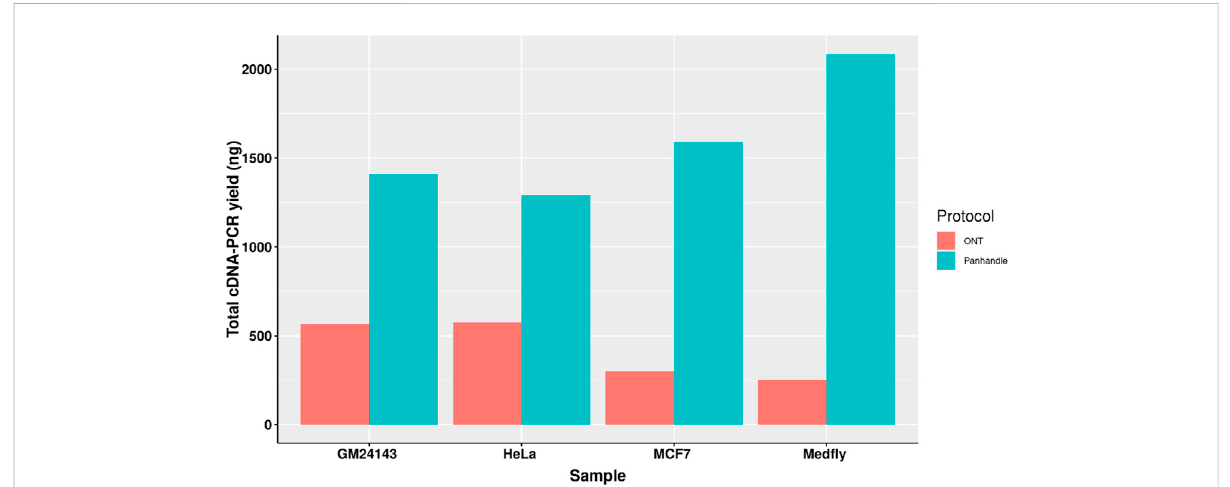
FIGURE 2 Total yield of PCR ampli fi ed cDNA. Total RNA from three human-derived cell lines and one from Mediterranean fruit fl y embryos (Med fl y) was reverse transcribed and ampli fi ed for 20 cycles either following the Oxford Nanopore Technologies ’ SQK-PCB109 (ONT) or our in-house protocol called Panhandle and the yield of puri fi ed amplicons measured.